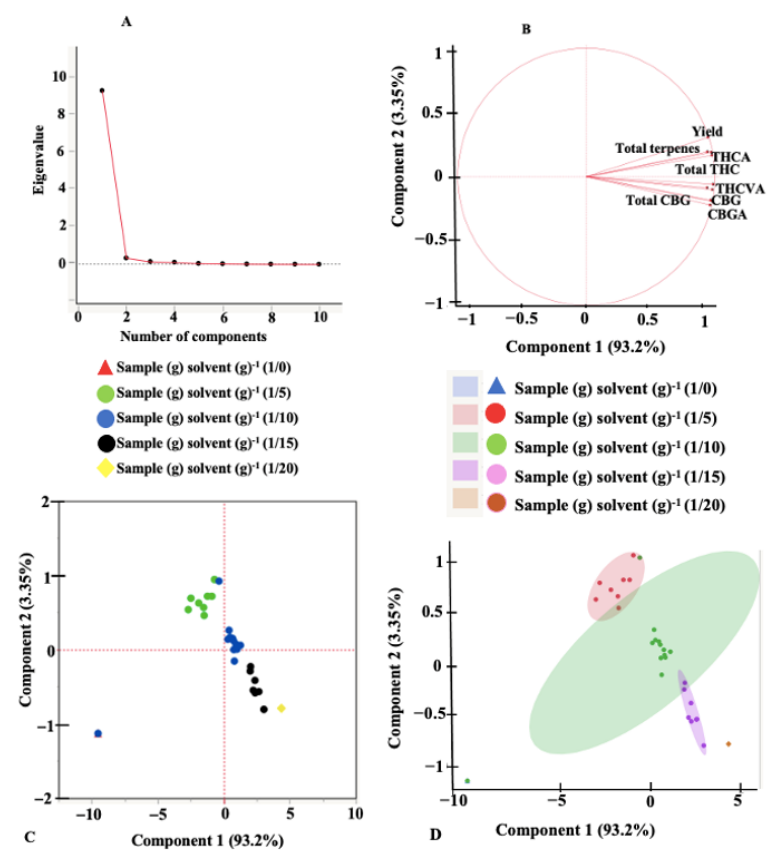
Figure 3. Principal component analysis plots. ( A ) scree plot, ( B ) loadings plot, ( C ) scores plot, and ( D ) scatterplot, for ultrasound-assisted extraction.